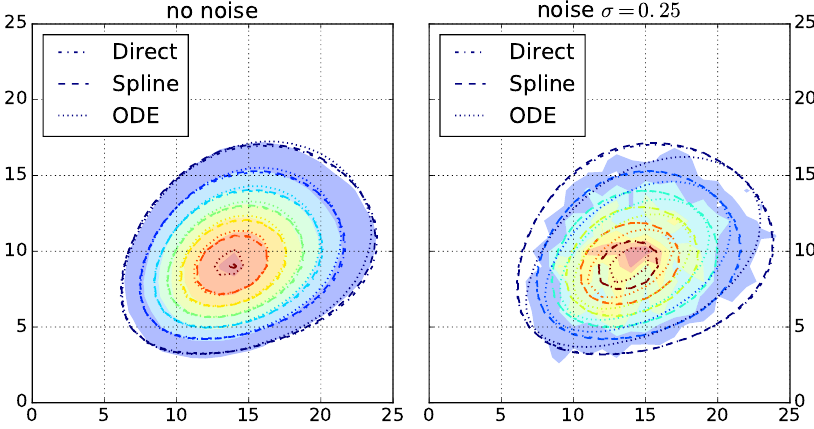
Figure 2. Filled contours: copolymer fingerprints of DP n = 25 computed by Monte Carlo simulations with no ( left ) and high applied noise ( right ). Contours: fingerprints computed by the geometric model using the best parameters computed by the optimization algorithms for each of the fingerprint-generating functions (direct, spline, and